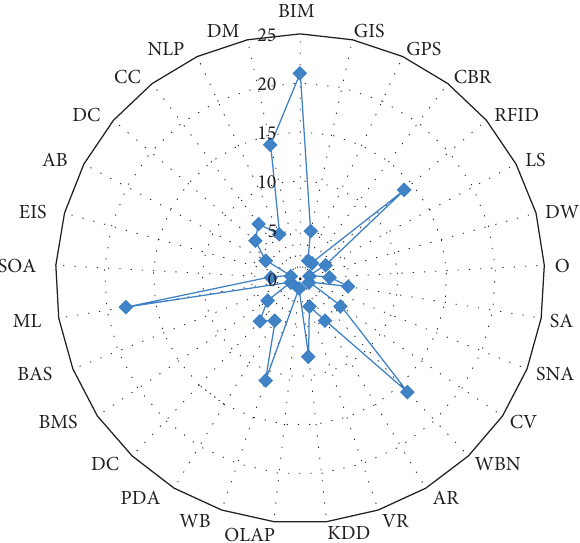
Figure 2: Total use frequency of each